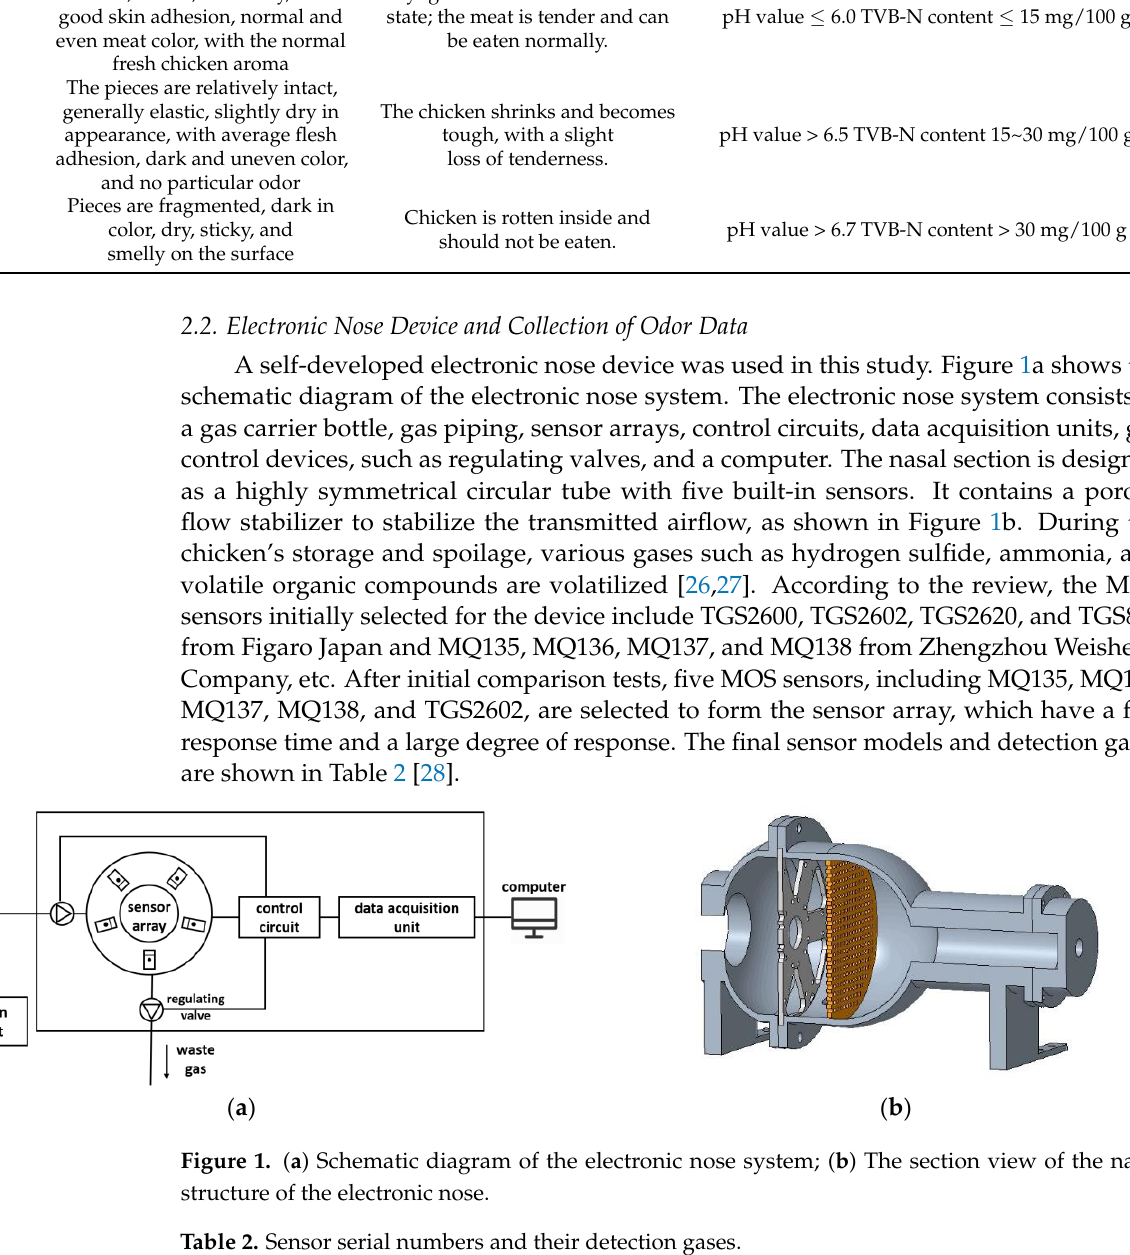
Table 1. Sensory grading scale for chicken.